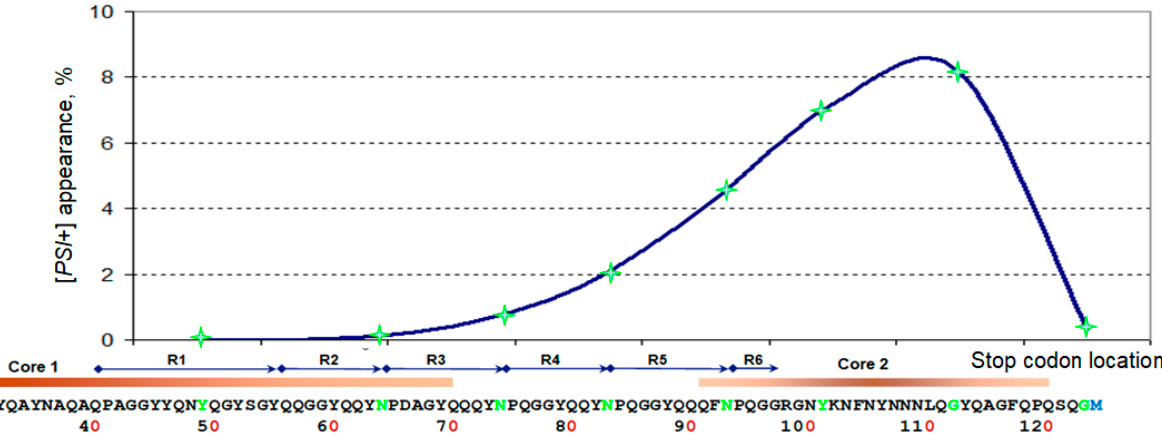
Figure 3. Dependence of the [ PSI + ] appearance frequency on the location of an inducer C-terminal residue (green) on the Sup35N sequence. The locations of oligopeptide repeats and prion Cores 1 and 2 typical for weak [ PSI + ] variants are shown.